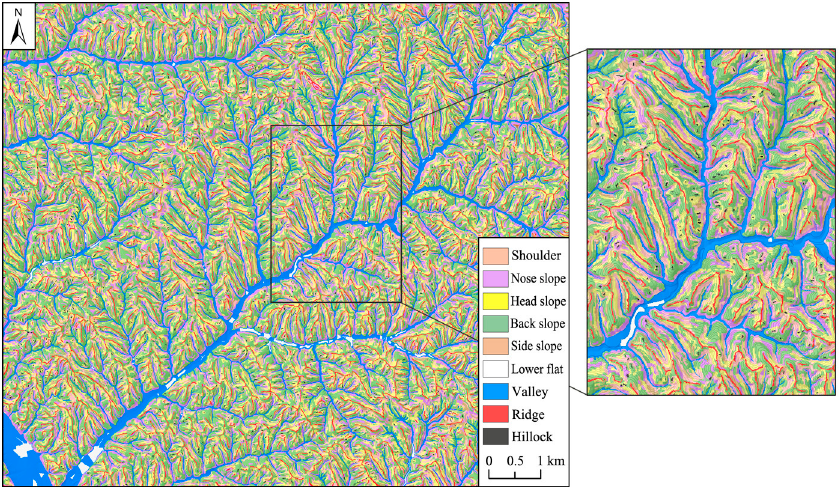
Figure 9. Terrain positions of the proposed classification method.